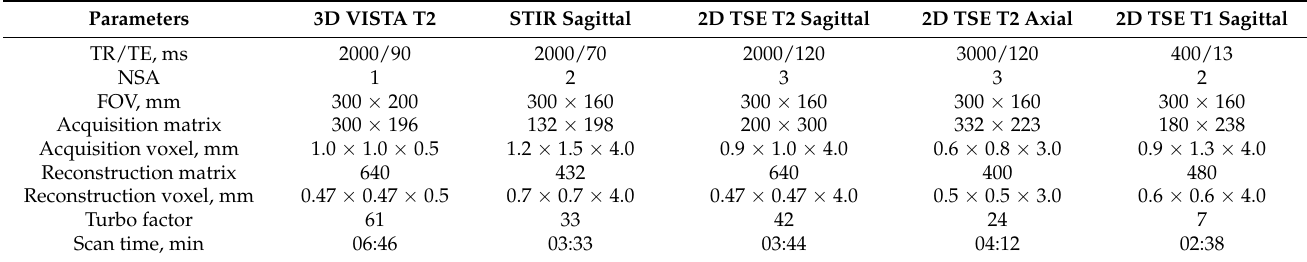
Table 1. High-resolution 3D VISTA magnetic resonance pulse parameters and a standard protocol for lumbar spine MRI. Parameters 3D VISTA T2 TR/TE,